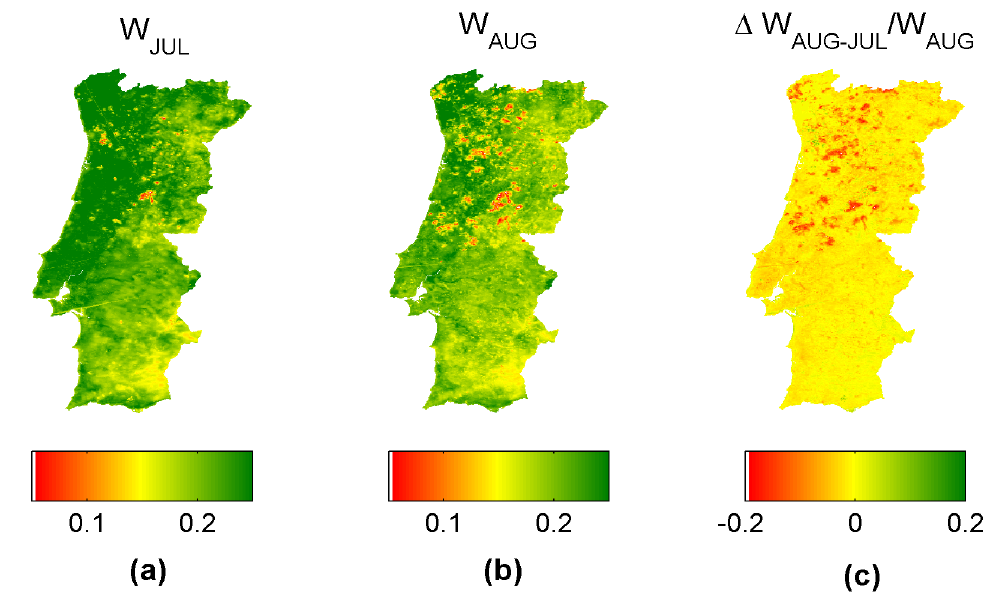
Figure 4 - Minimum value composites of W for July (a) , August (b) 2005. Normalized differences between the composites of August and July (c)